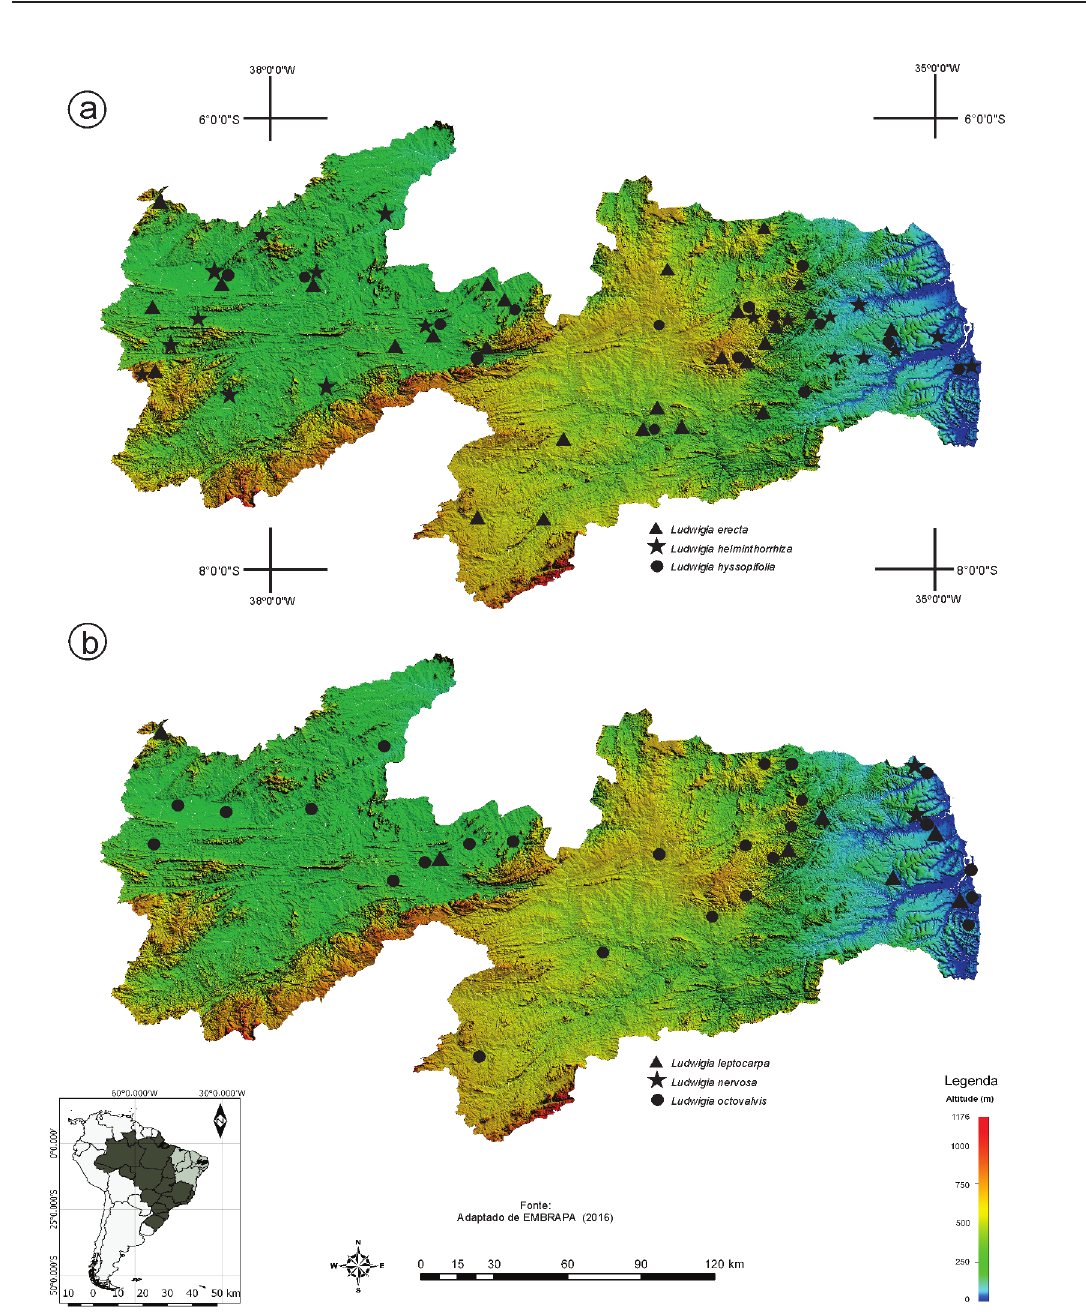
Fig. 5. Map showing the geographic distribution of Ludwigia L. species in the Paraíba State, Brazil. a . Ludwigia erecta (L.) H.Hara ( ), L. helminthorrhiza (Mart.) H.Hara ( ), L. hyssopifolia (G.Don) Exell ( ). b . L. leptocarpa (Nutt.) H.Hara ( ), L. nervosa (Poir.) H.Hara ( ), L. octovalvis (Jacq.) P.H.Raven ( ). Maps by E. de Morais